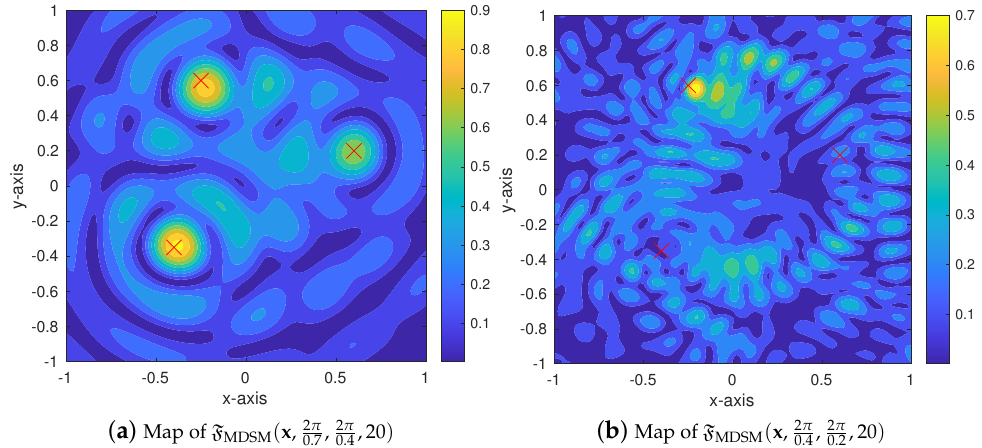
Figure 4. (Example 2) Simulation results with d = ( 1,0 ) . The red-colored marks × denote the locations of cracks.